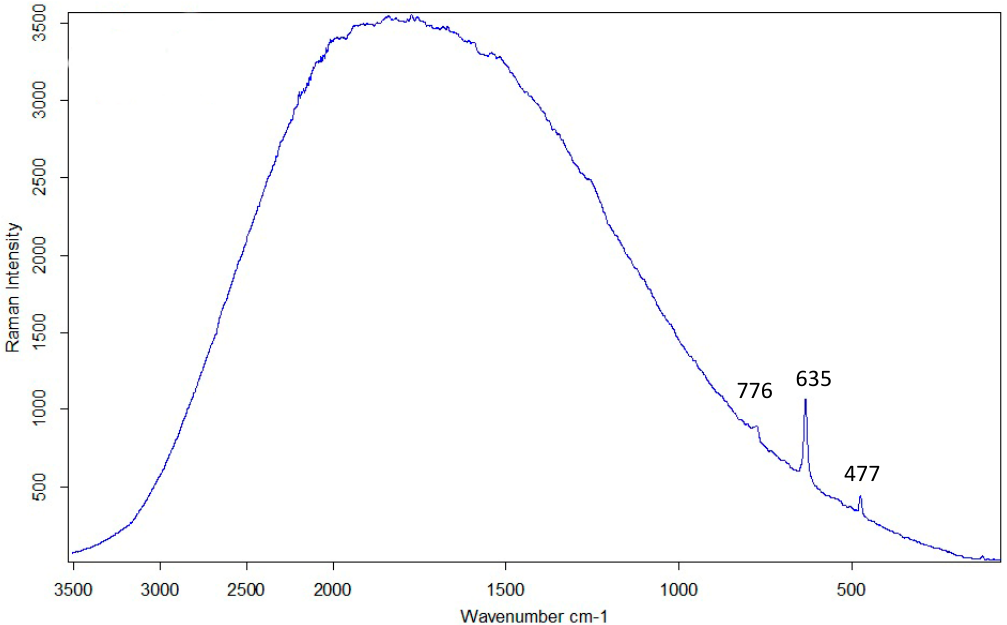
Figure 23. μ -Raman spectrum acquired on euhedral crystals with bands at about 776, 635, and 477 cm − 1 ,